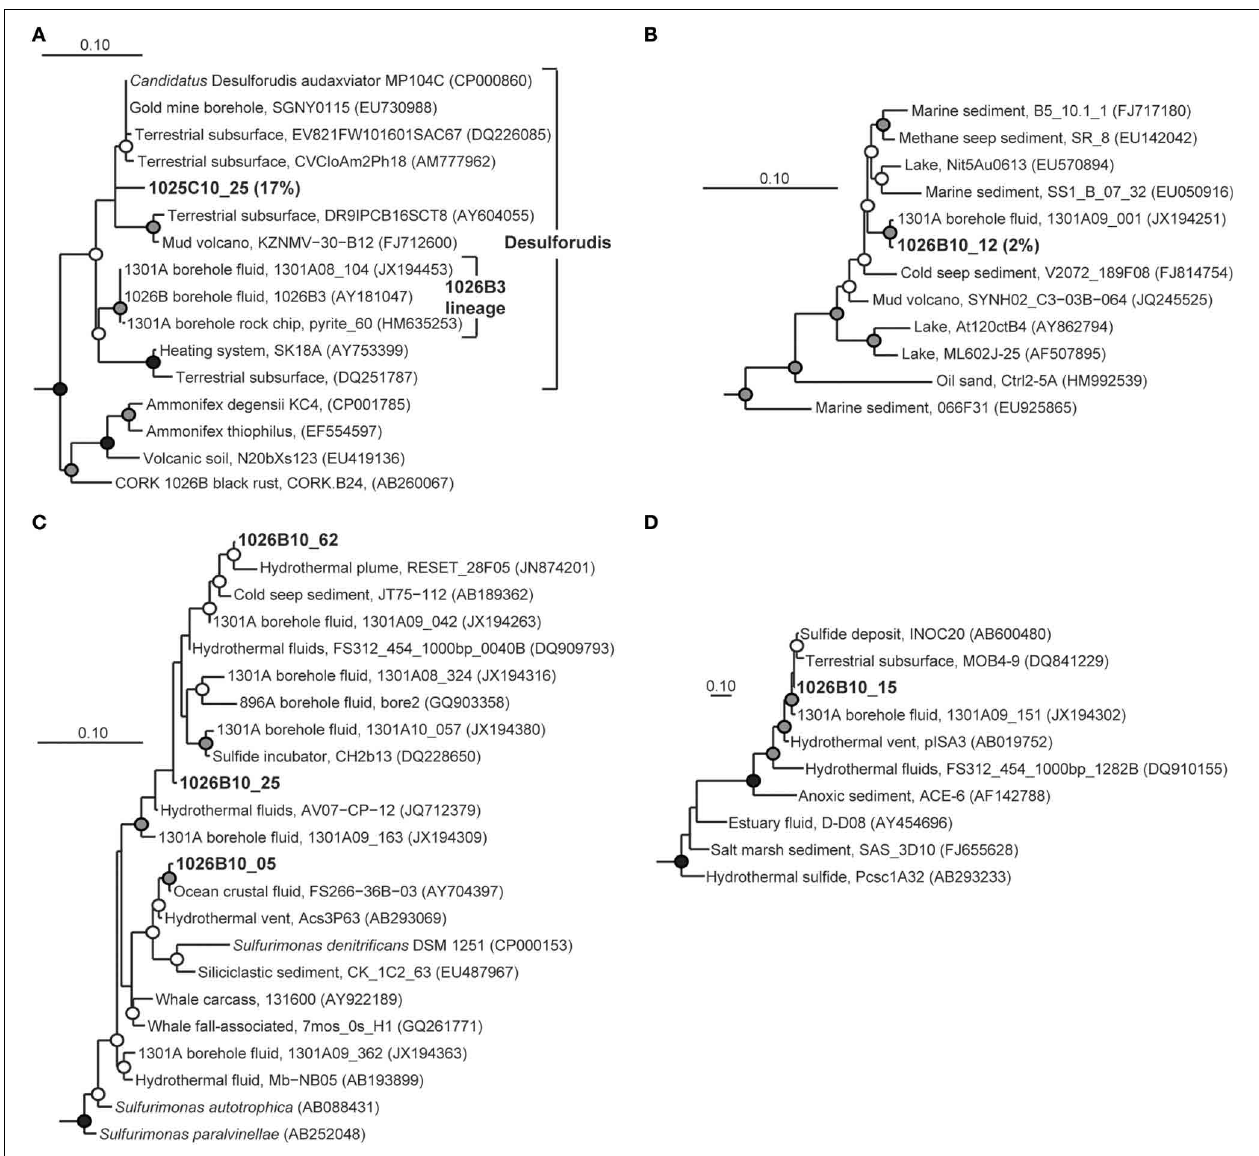
FIGURE 4 | Phylogenetic relationships of SSU rRNA gene clones from Holes 1025C and 1026B fluids within the phylum Firmicutes , related to (A) Candidatus Desulforudis audaxviator, (B) RF3, (C) Sulfurimonas of the bacterial phylum Epsilonproteobacteria , and (D) DHVEG-6 of the